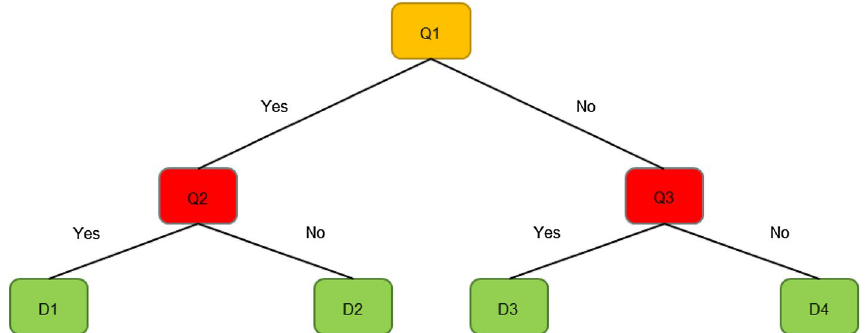
Figure 2. G.B.T approach.